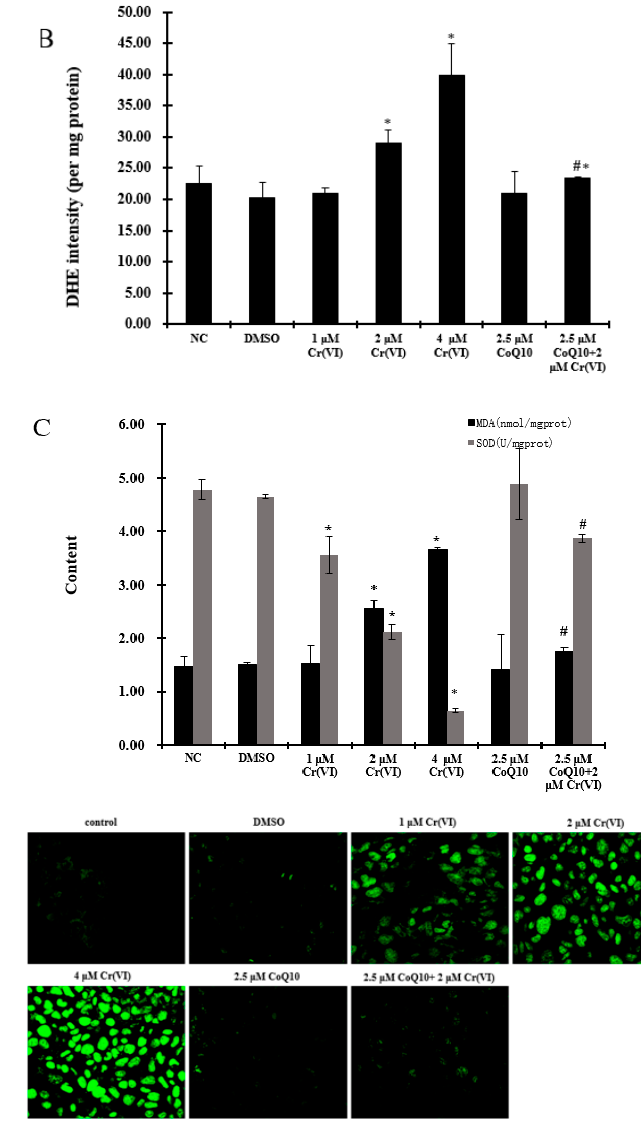
Figure 2. CoQ10 attenuates oxidative damage induced by Cr(VI). ( A ) Quantification of ROS levels. Effect of CoQ10 on Cr(VI)-induced ROS accumulation in L-02 hepatocytes and quantitation by fluorescence spectrophotometry; ( B ) After L-02 hepatocytes were treated with Cr(VI) (0~4 µ M) for 24 h, with or without CoQ10 pretreatment for 2 h, O 2 − generation was detected with dihydroethidium; ( C ) CoQ10 reduced the oxidative damage induced by Cr(VI). The cells were treated with Cr(VI) (0~4 μ M) for 24 h, with or without CoQ10 pretreatment, and MDA was detected by the MDA detection kit as the end product of lipid oxidation. SOD was measured using the total superoxide dismutase activity assay, which involves the inhibition of superoxide-induced chromogen chemiluminescence by SOD; ( D ) Effect of CoQ10 on Cr(VI)-induced ROS accumulation. The cells were incubated with 5 μ M of CellROX ® Green Reagent for 30 min and observed under a confocal microscope using a 40× objective. Brighter green fluorescence indicated greater ROS accumulation. The data are presented as mean ± SD ( n = 6). * p < 0.05 compared with the control group; # p < 0.05 compared with the 2 μ M Cr(VI) treatment group.